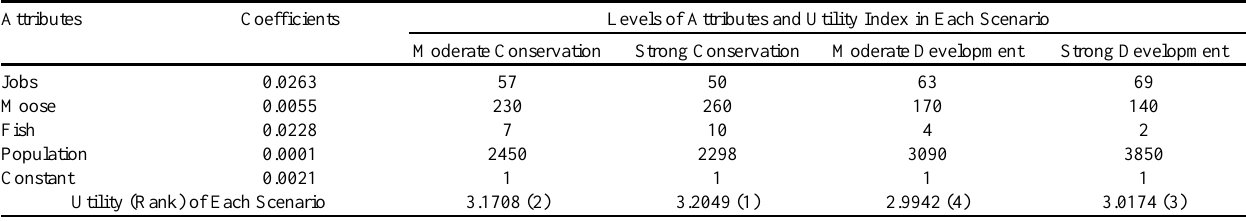
Table 5 . Comparison of